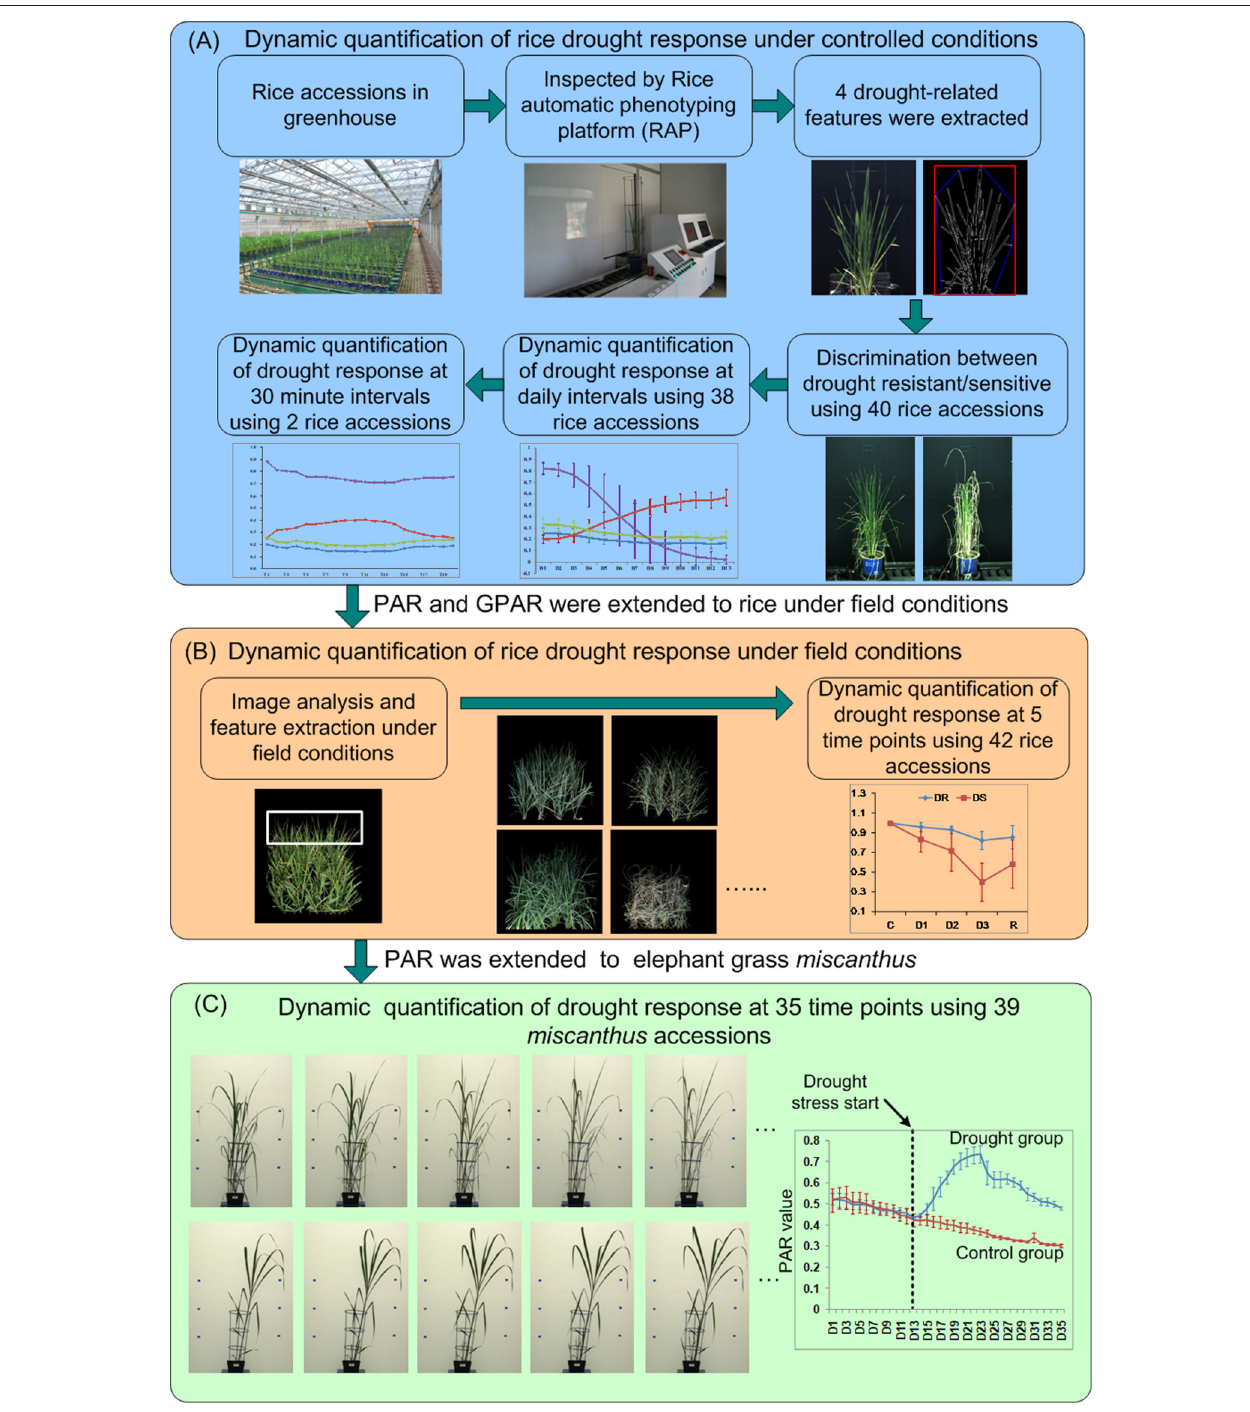
FIGURE 1 | The experimental design for dynamic quantification of drought response for (A) rice under controlled conditions, (B) rice under field conditions, and (C) Miscanthus under controlled conditions.